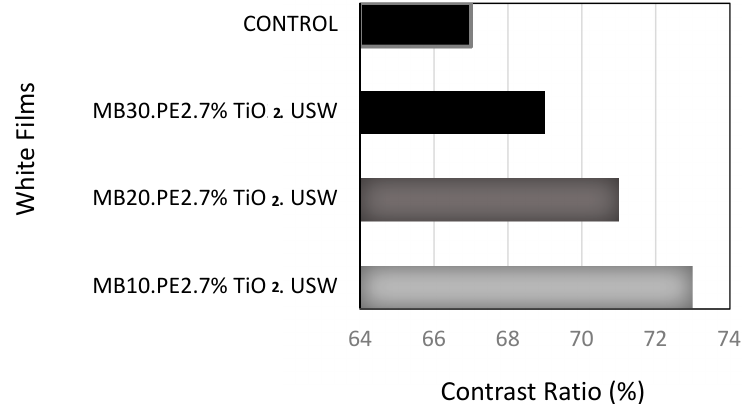
Figure 3. Comparison of the contrast ratio of the control (MB10.PE2.7% TiO 2 control) film versus white LDPE films, related to the optic effect achieved by dispersion of 7 wt% of TiO 2 , using masterbatch compounds concentrated by ultrasound-assisted extrusion method at 10, 20 and 30 wt% of TiO 2 , blended in PE matrix of MFI 2.